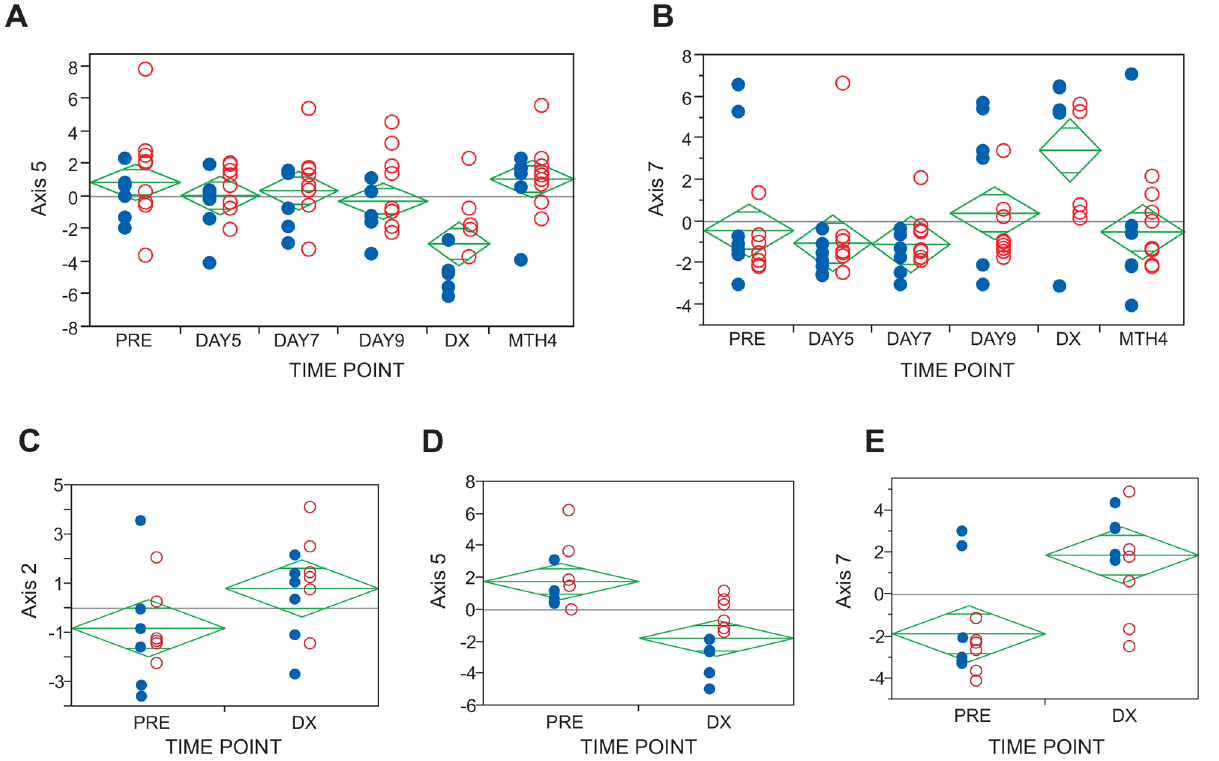
Fig 3. Axis of variance analysis. Each plot shows the differences in Axis scores at 6 different timepoints for RT-qPCR ( A and B ) and two for RNASeq (C-E ); Blue solid point represents Cali, and red open circles represent Buenaventura. P-values for the effect of timepoint including location as a fixed effect and individual as a random effect in the RNASeq data are 0.016 (Axis 2), 4.4×10 -5 (Axis 5), 0.0003 (Axis